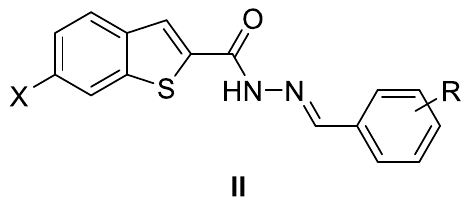
Figure 3. General structure of set II derivatives.